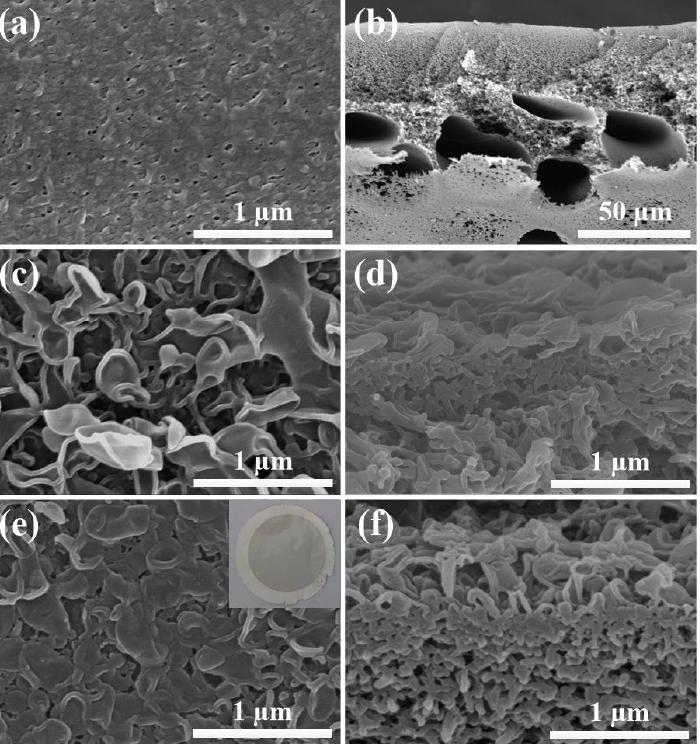
Figure 6. SEM images of surfaces and the cross-section for the PSF membrane ( a , b ), TFC membrane ( c , d ) and TFN-0.1 membrane ( e , f ). ( c , d ) and TFN-0.1 membrane ( e , f